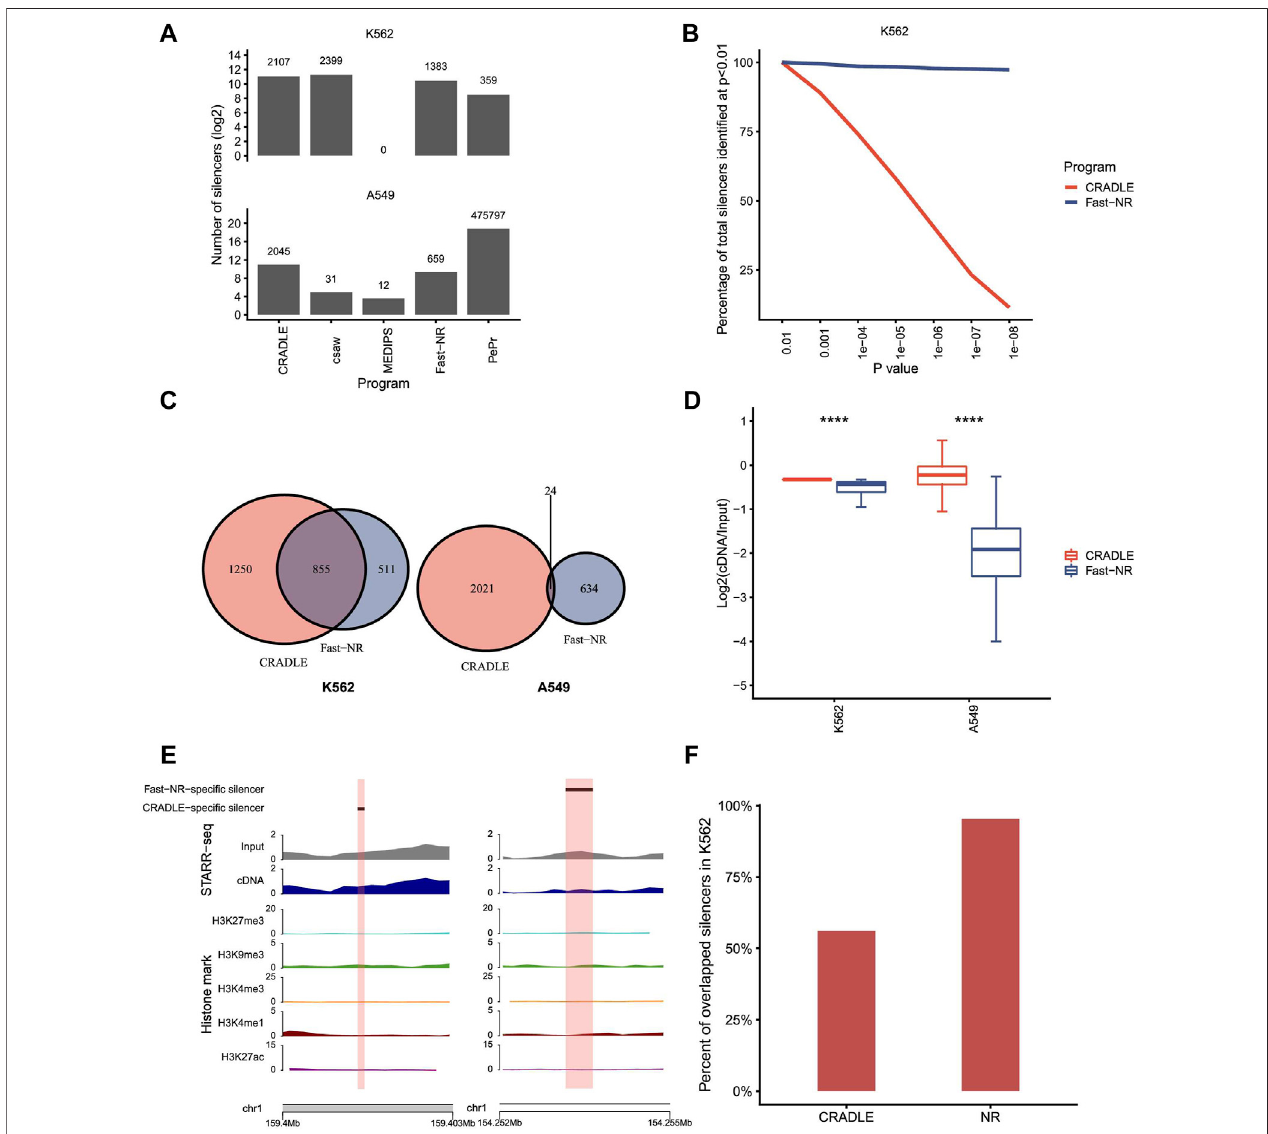
FIGURE 3 | Program performance comparison on STARR-seq datasets. (A) The number of silencers identi fi ed by different programs. p value < 10 − 5 . (B) The percentageofsilencersidenti fi edbyCRADLEandFast-NRatdifferentcon fi dencelevels.Thenumberofsilencersidenti fi edat p < 10 − 2 issetat100%. (C) Venndiagrams of silencers identi fi ed by Fast-NR and CRADLE in K562 and A549, respectively. p value < 10 − 5 . (D) Reads ratio (reporter cDNA/input inserts) distribution for silencers identi fi ed only by CRADLE or Fast-NR in K562 and A549, respectively. (E) Exemplary silencers identi fi ed only by CRADLE (left) or by Fast-NR (right). (F) Percentages of Fast-NR- and CRADLE-identi fi ed silencers ( p < 10 − 5 ) reported by Doni Jayavelu et al.